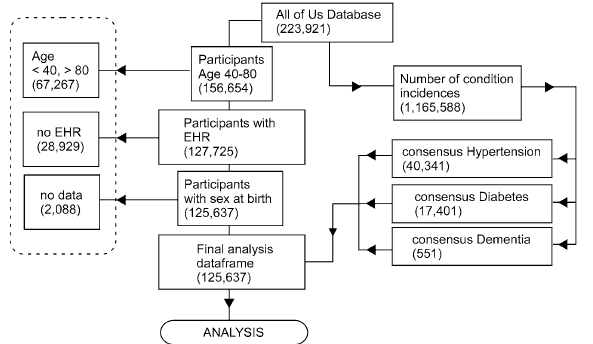
Figure 1. Overview of data inclusion/exclusion criteria from AoU Researcher Workbench to final participant cohort and analysis data frame. All steps were performed in R and are outlined in the Analysis workbook 01. Briefly, participant data were screened to exclude patients < 40 or > 80 years of age, and who did not have EHR data (defined as one visit or more to a health provider). Of the data containing medical conditions, we identified each unique participant ID with consensus diabetes, hypertension, or dementia (Supplementary Table 1) and annotated the data accordingly.